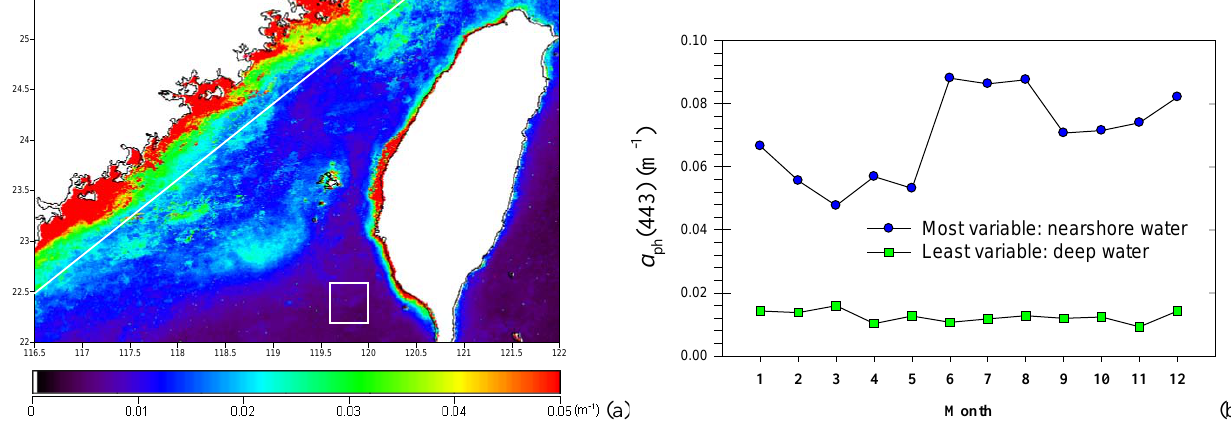
Fig. 4. (a) Annual mean standard deviation of Aph; (b) the annual cycle of Aph in the most variable coastline (west of the white line alongshore on a ) and least variable deep water (the square at the right bottom of a )